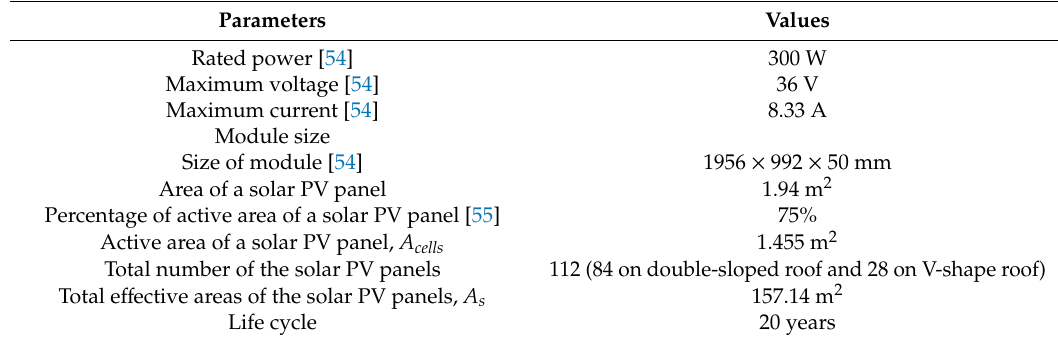
Table 3. Parameters of the solar photovoltaic (PV) system.